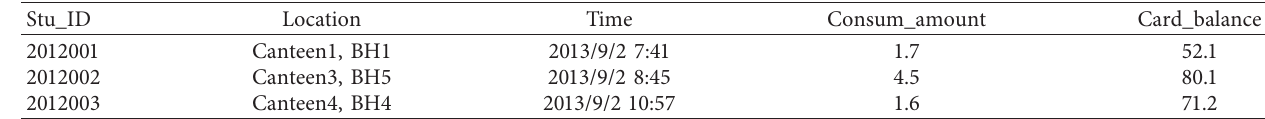
Table 3: Data format of consumption